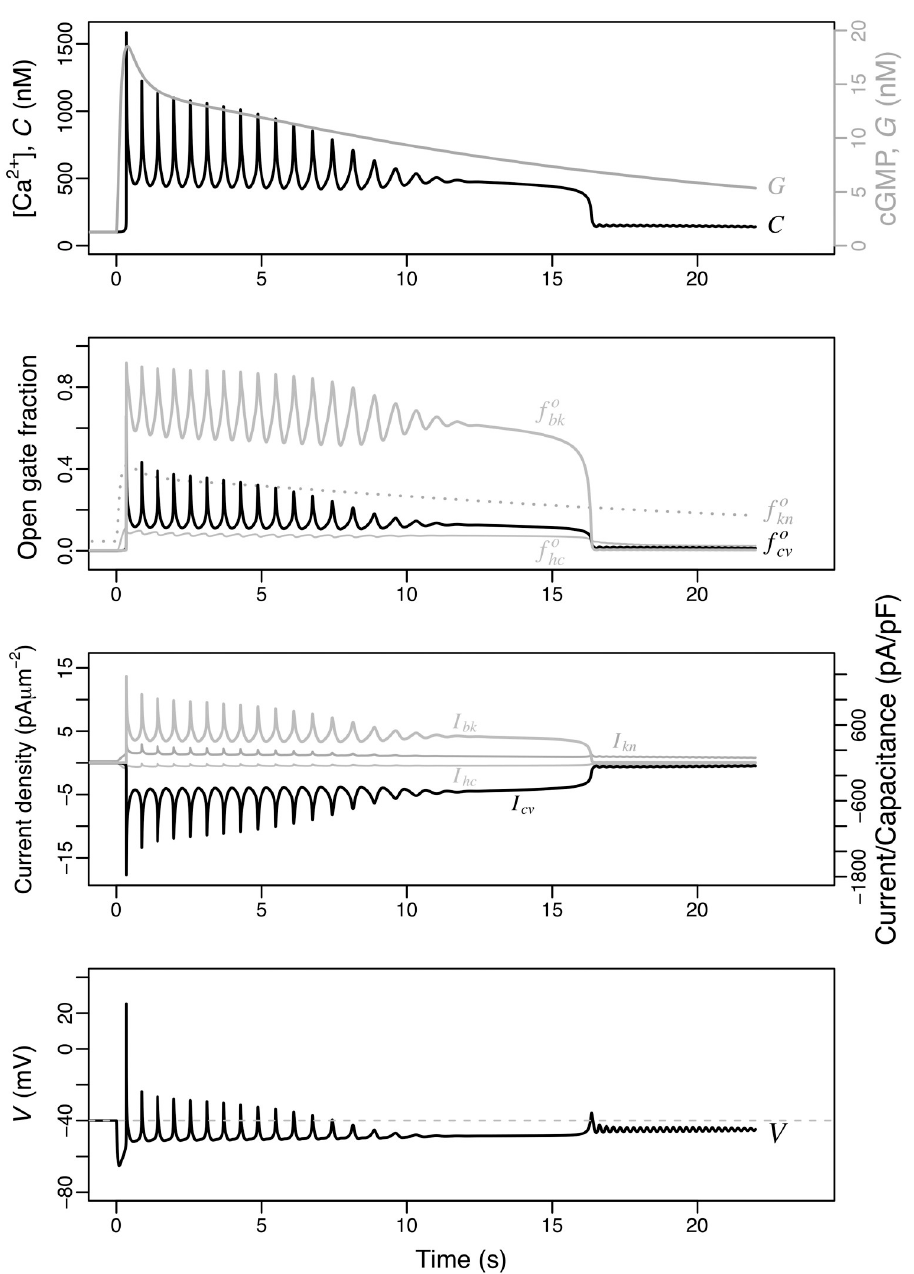
Fig 4. Dynamics of the model featuring the Ca V +BK module. The state space is { S , R F , R H , R L , G , f o C }. As in Fig 2, the initial stimulus is S (0) = 25 nM is used. From top to bottom, the numerical solutions obtained with the parameters listed in Table 2 are shown for: [Ca 2+ ] i ( C ) together with cGMP concentration ( G ), open channel fractions, ionic currents and membrane potential. The ionic currents are displayed in current densities (left axis) and as current normalised by capacitance (right